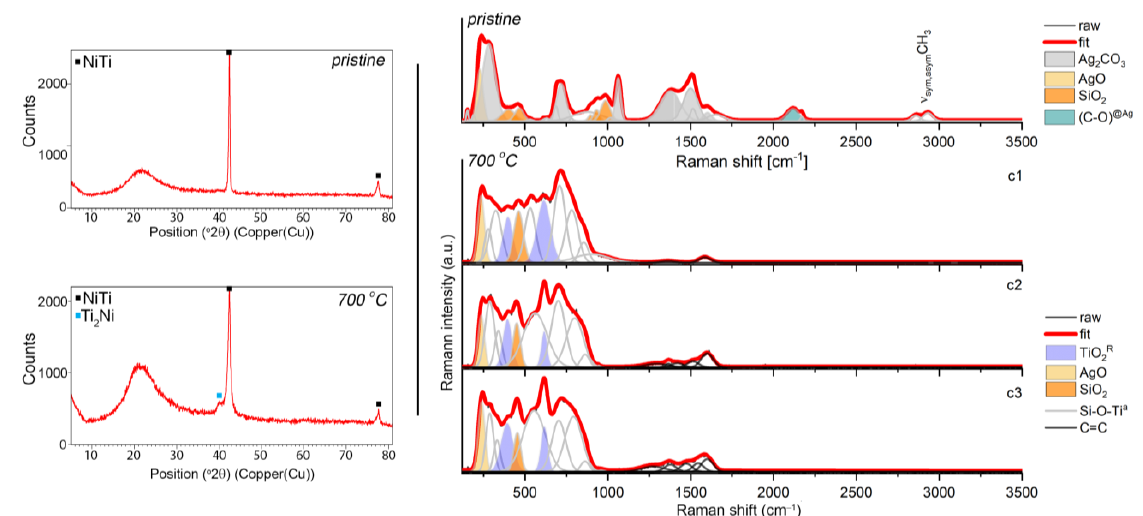
Figure 3. XRD data ( left panels ) and Raman spectra ( right panels ) that were extracted from the K -means cluster analysis considering the pristine Ag-SiO 2 composite and the composite that was sintered at 700 °C per 2 h deposited on TiO 2 /NiTi substrate. The band fitting of the Raman data was analyzed using the Grams 9.2 software package and the Voigt function, and the individual chemical phases are color-marked.